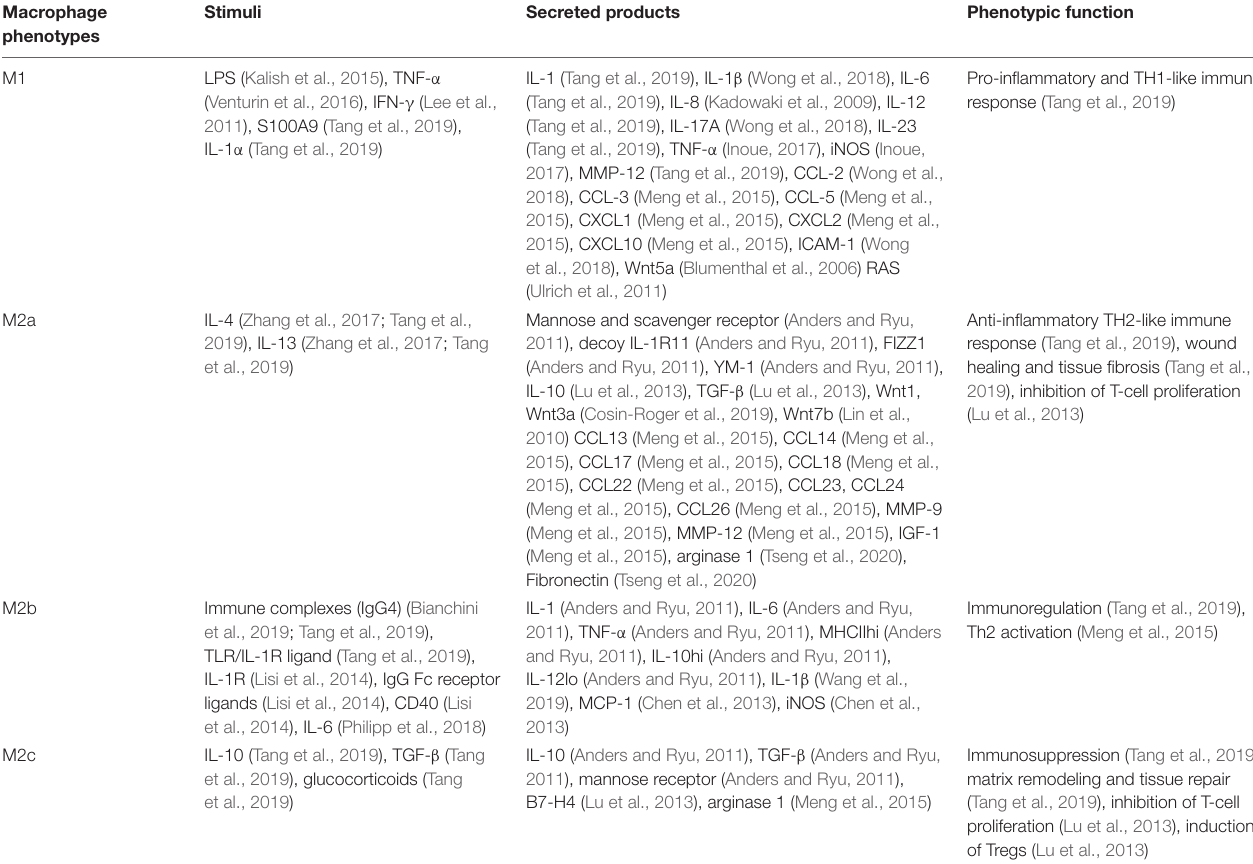
TABLE 1 | Macrophage phenotypes, stimuli, Secreted products, and